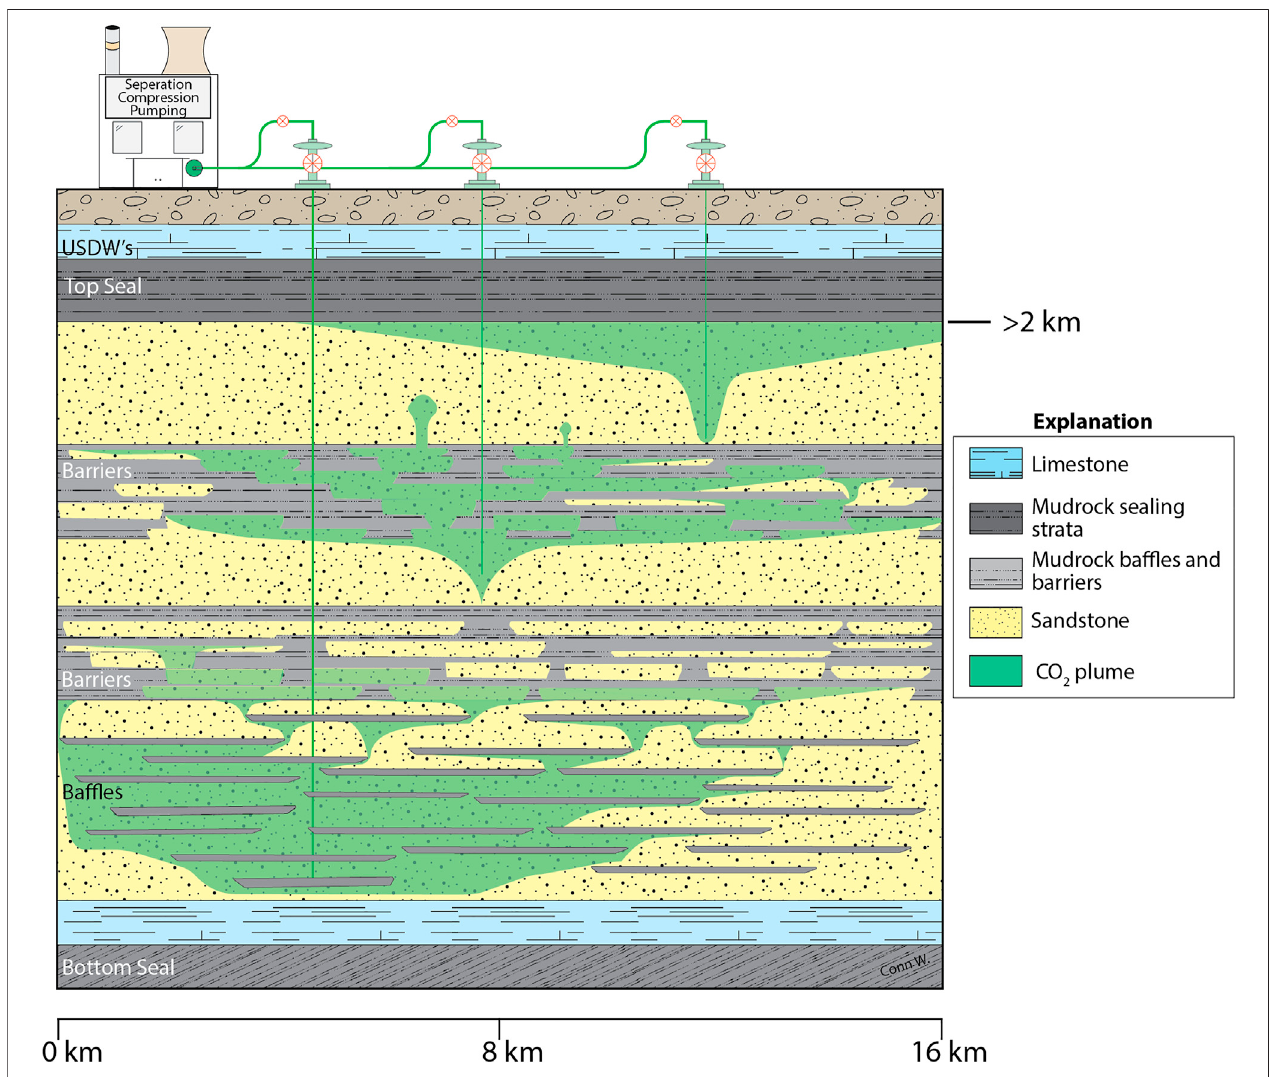
FIGURE 11 | Conceptual model on mudstone baf fl es and barriers that de fi ne heterogeneous reservoirs.